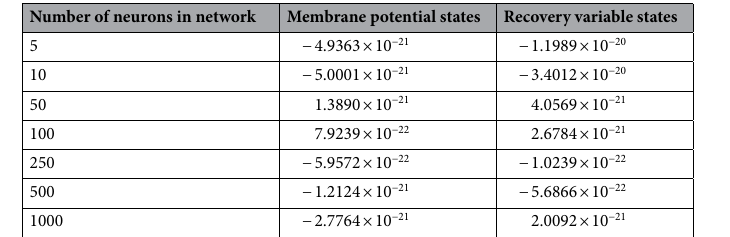
Number of neurons in network Membrane potential states Recovery variable